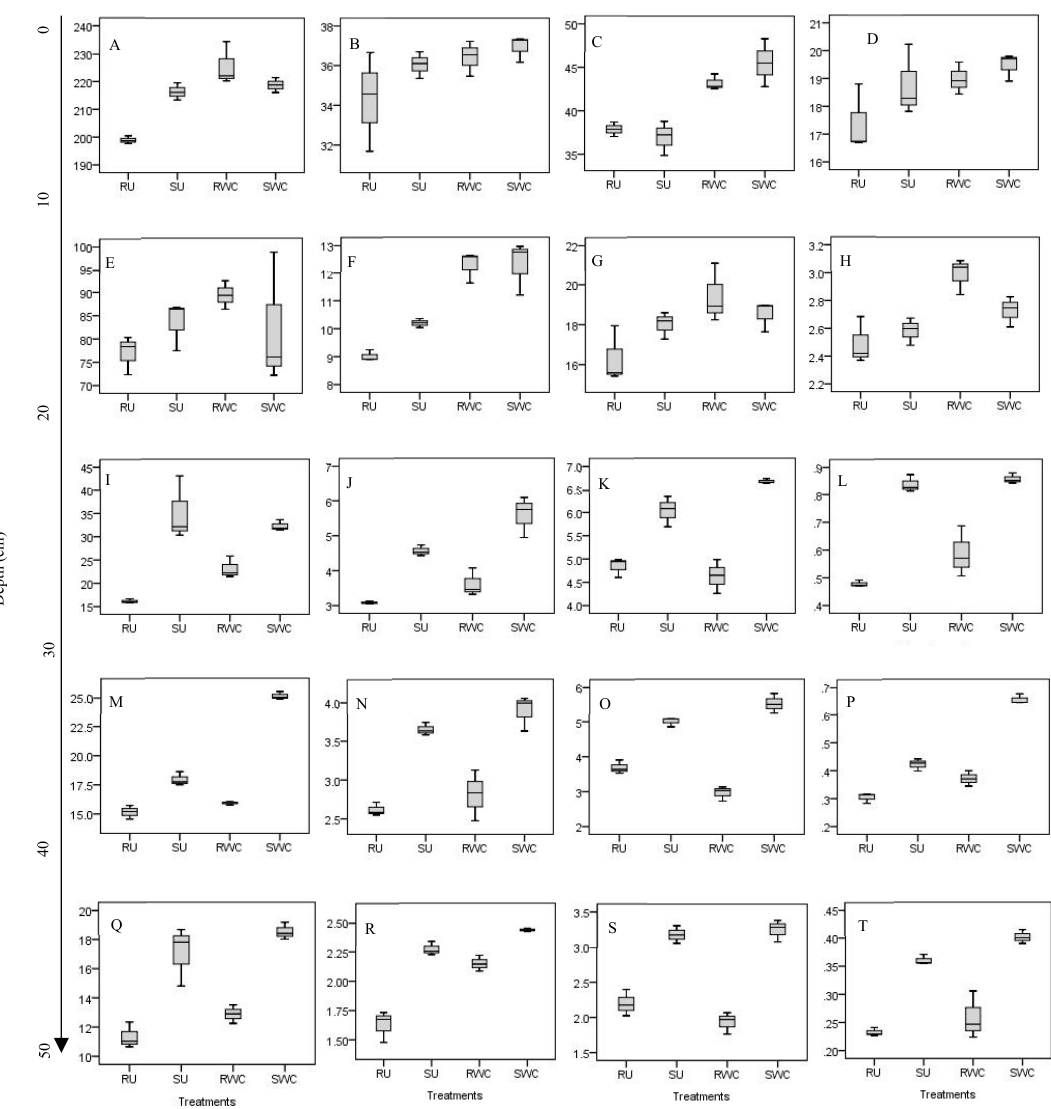
Figure 6. Root length ( A , E , I , M , Q ; m), root surface area ( B , F , J , N , R ; m 2 10 − 2 ), root volume ( C , G , K , O , S ; cm 3 ) and root weight ( D , H , L , P , T ; g), in the 0–50 cm soil layer at R2 under the different cultivation modes in 2014. RU, rotary tillage plus uniform plant spacing (CK); SU, subsoil tillage plus with uniform plant spacing; RWC, rotary tillage plus wide–narrow plant spacing and chemical regulator; SWC, subsoil tillage plus wide–narrow plant spacing and chemical regulator application.